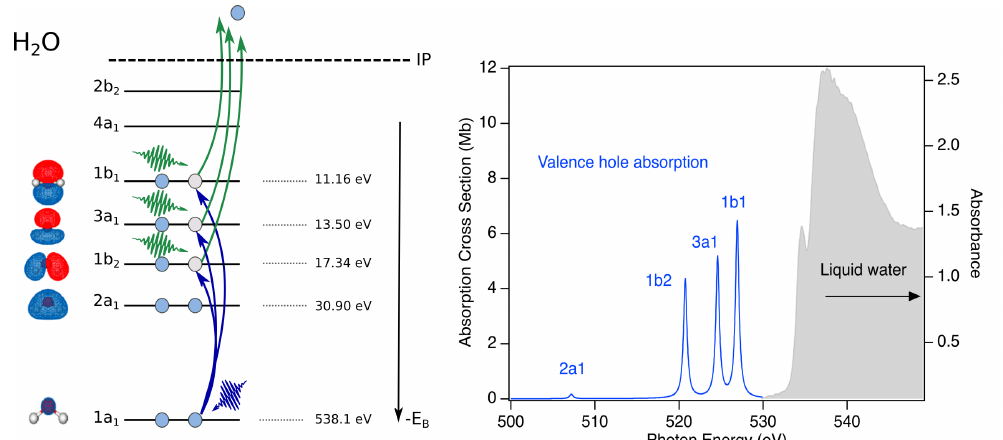
Figure 3. Schematic of a potential X-ray pump/X-ray probe transient absorption study of water radiolysis. Left: X-ray pump photons (green) eject an electron from any of the valence or inner- valence orbitals 1 b 1 ,3 a 1 ,1 b 2 ,2 a 1 . X-ray probe photons (blue) selectively induces transitions from the 1s core level to the vacancies, (e.g., 1 a 1 → 1 b 2 ). Right: Absorption spectrum of liquid water